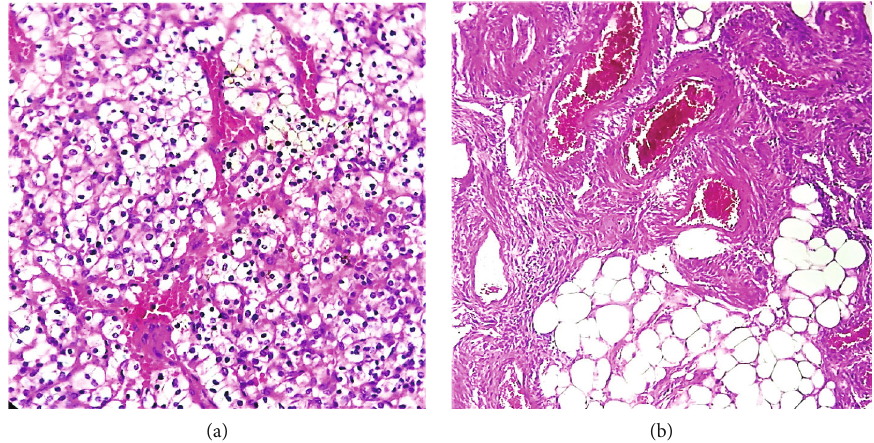
Figure 3: Hematoxylin and eosin staining demonstrating as follows. (a) CCRCC composed of nests of cells with clear cytoplasm, surrounded by a network of abundant thin-walled blood vessels. (b) AML composed of aggregates of thick-walled blood vessels, admixed with mature adipose tissue and smooth muscle cells.